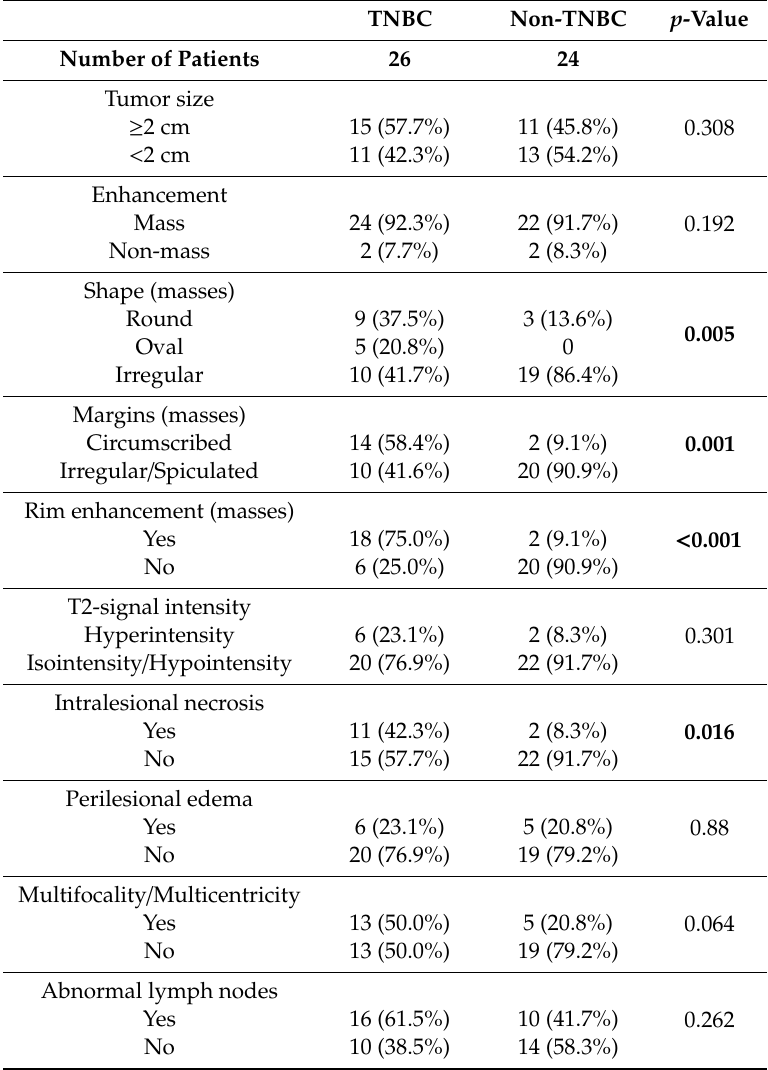
Table 1. MRI features. Statistically significant p -values are